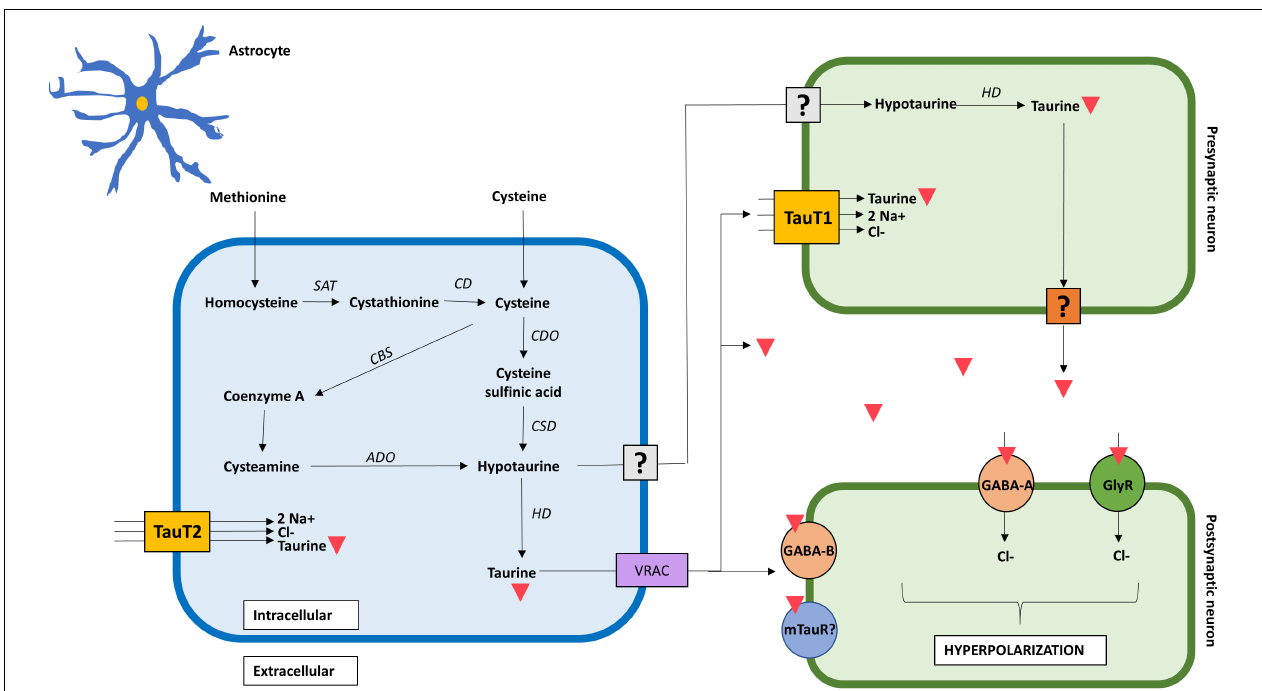
FIGURE 1 | Mechanistic action of taurine in the brain. Taurine is synthesized in astrocytes from extracellular methionine and cysteine through three distinct pathways. It is exported as hypotaurine or taurine into the extracellular space; however, the mechanism in which hypotaurine exits the astrocyte and enters the neuron remains uncertain. Transport of taurine depends on TauT1 and TauT2 transporters, for neurons and astrocytes, respectively. The mechanism in which taurine exits the pre-synaptic neuron remains to be confirmed. Taurine acts as a full agonist for GABA A , GABA B , and glycine receptors in the post-synaptic neuron, increasing chloride conductance, and thus, hyperpolarizing the cell. The presence of a post-synaptic taurine receptor remains controversial. Taurine is represented by an inverted red triangle. ADO, aminoethanethiol dioxygenase; CBS, 2-cystathionine ß-synthase; CD, cysteine desulfurase/ γ -cystathionase; CDO, cysteine dioxygenase; CSD, cysteine sulfinate decarboxylase; GlyR, glycine receptor; HD, hypotaurine dehydrogenase; TauT1, taurine transporter type 1; TauT2, taurine transporter type 2; SAT, S-adenosyl transferase; uncertain receptor/transporter–represented by a question